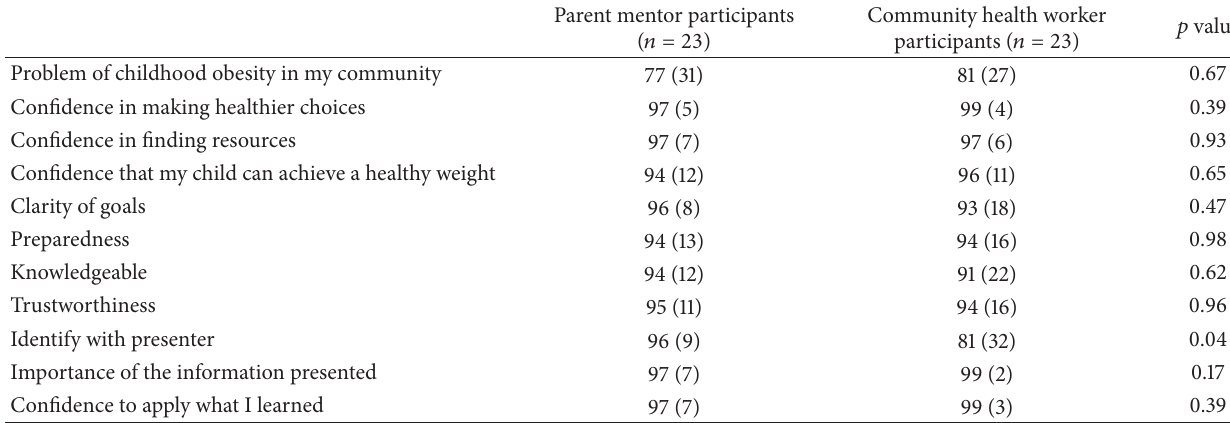
Table 1: Parent participant responses by randomization assignment to parent mentor or community health worker regarding perceptions of the parent mentor or community health worker and their own confidence regarding their child’s weight status. All scales with a possible range from 0 to 100, reported as mean (SD) using independent samples 𝑡